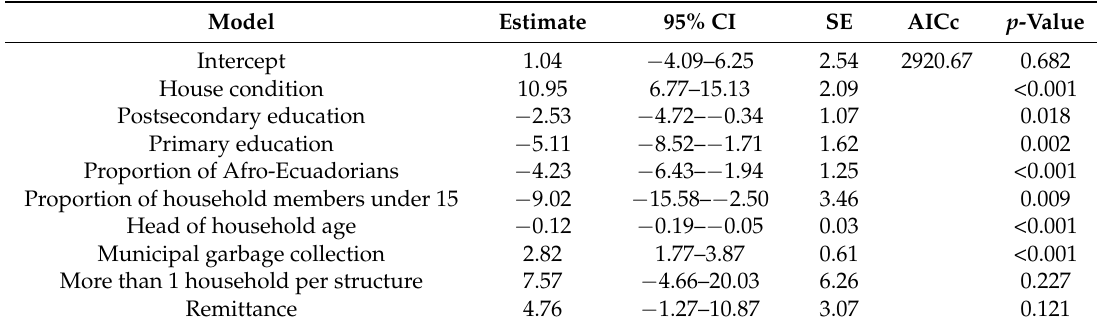
Table 3. Top negative binomial model used in determining which social-ecological factors are important to dengue